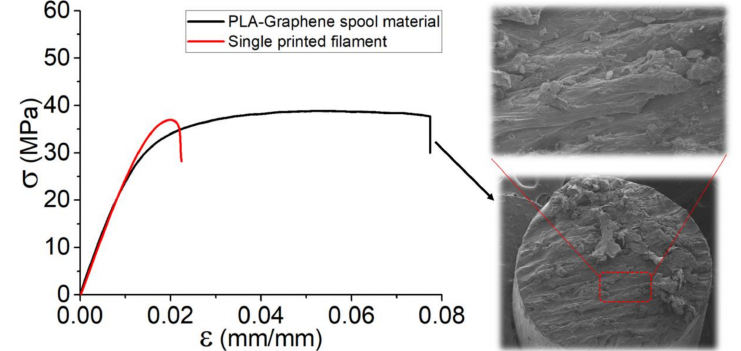
Figure 2. Tensile curves of spool material and single printed